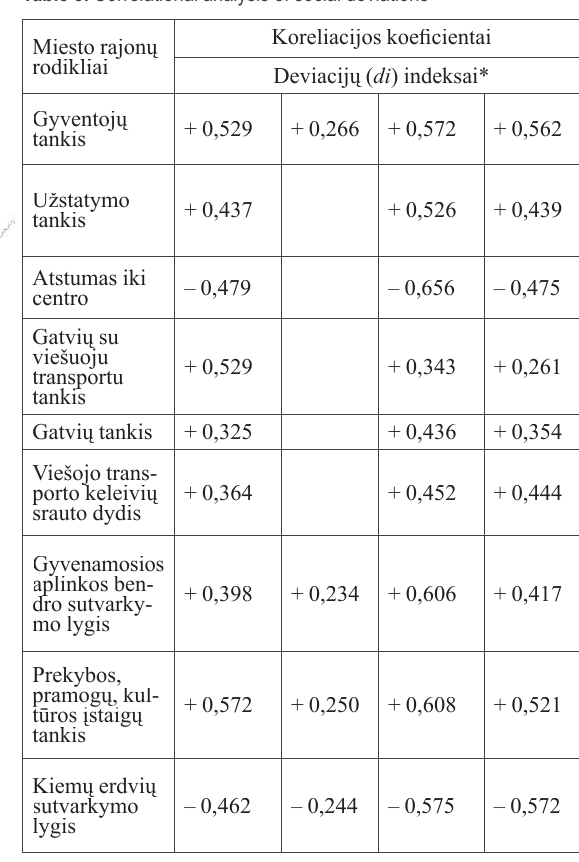
Table 3. Correlational analysis of social deviations